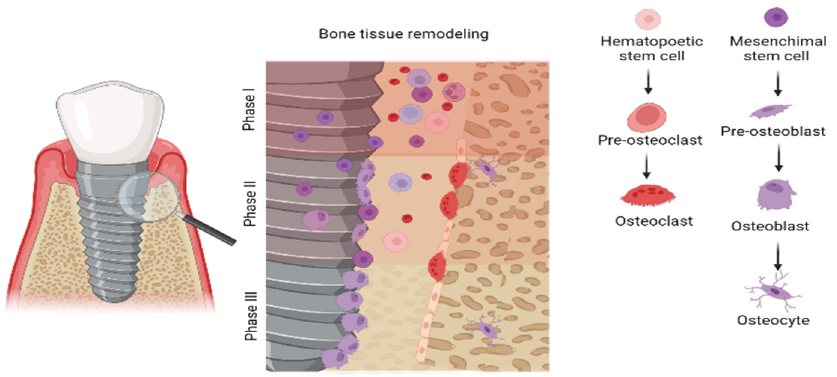
Figure 1. Mechanism of bone tissue remodeling after peri ‐ implantitis treatment. The figure was cre ‐ ated with BioRender.com. created with